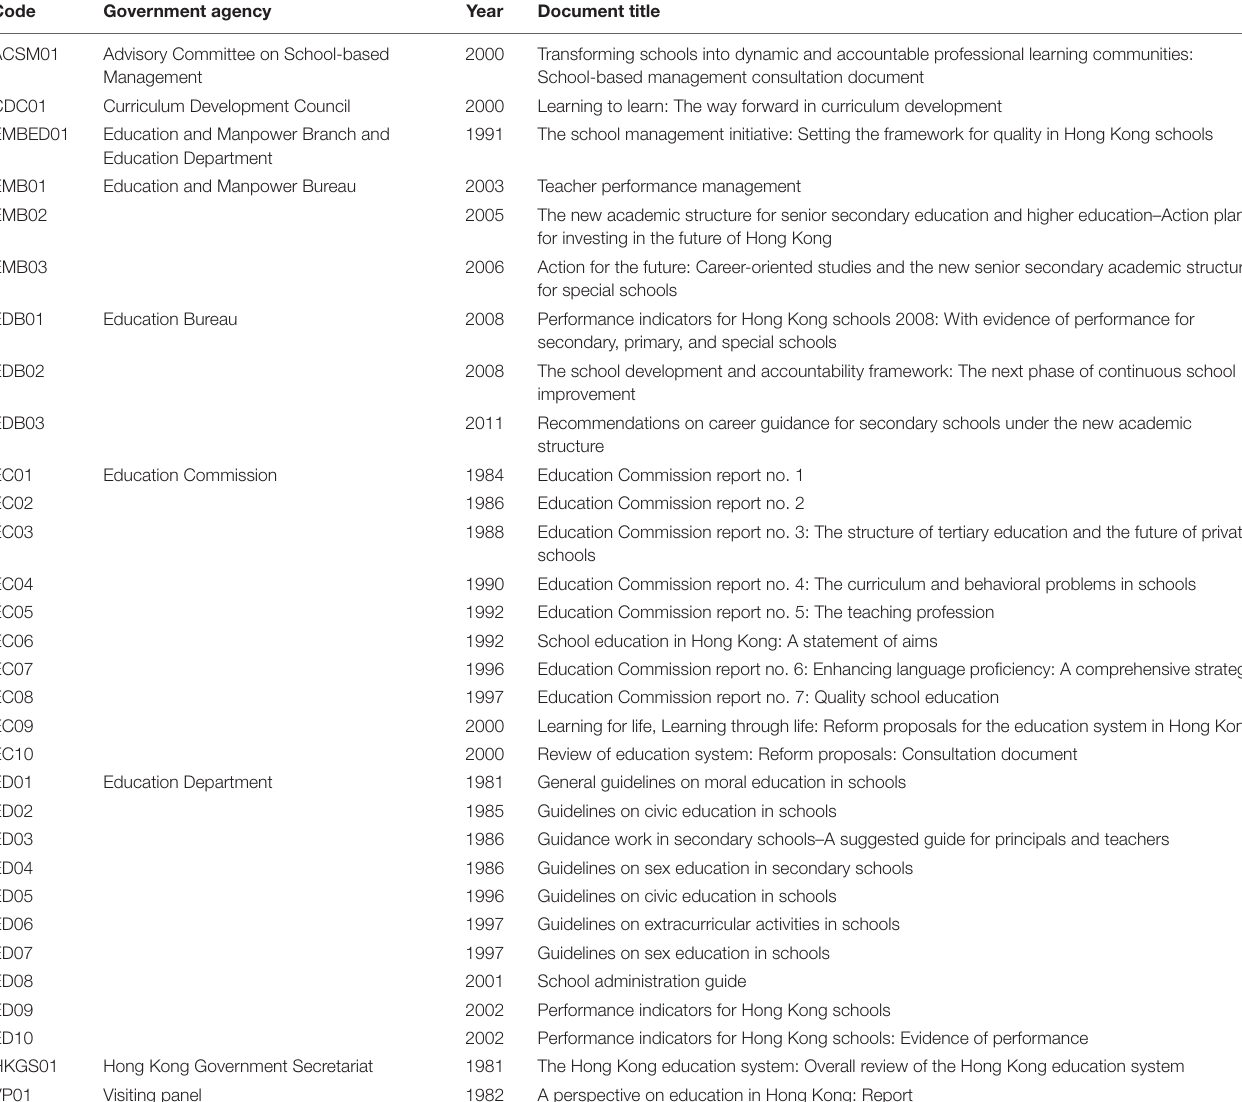
TABLE 3 | Hong Kong education policy documents collected for the